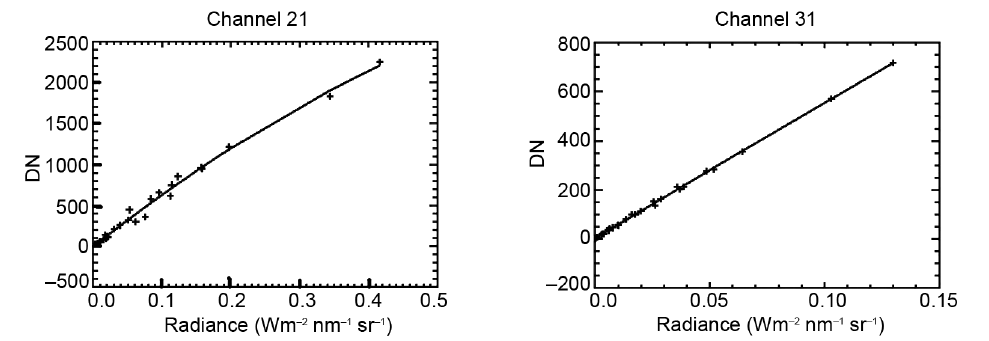
Fig. 3. Best fit of the 18 radiance values for channel 21 (second polynomial fit) and channel 31 (linear fit) to derive the calibration curves.